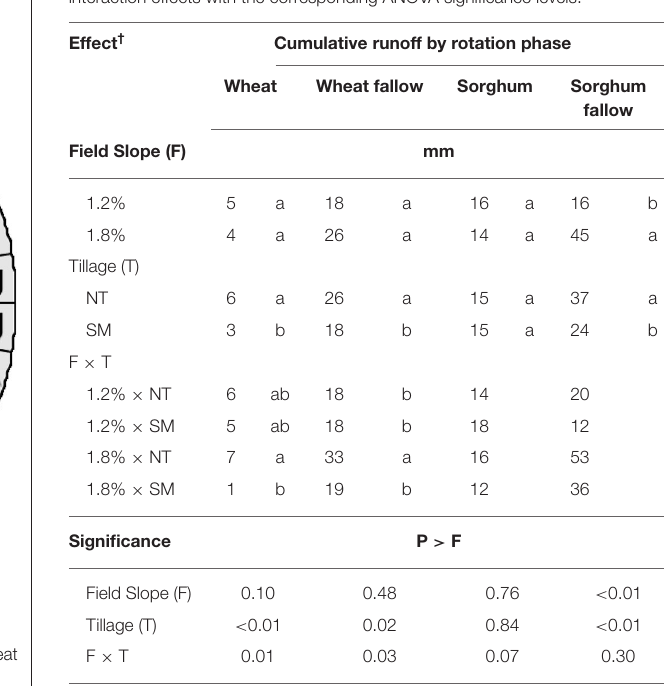
TABLE 1 | Mean cumulative runoff, mm, from wheat, fallow after wheat, sorghum, and fallow after sorghum rotation phases for field slope, tillage, and their interaction effects with the corresponding ANOVA significance levels.